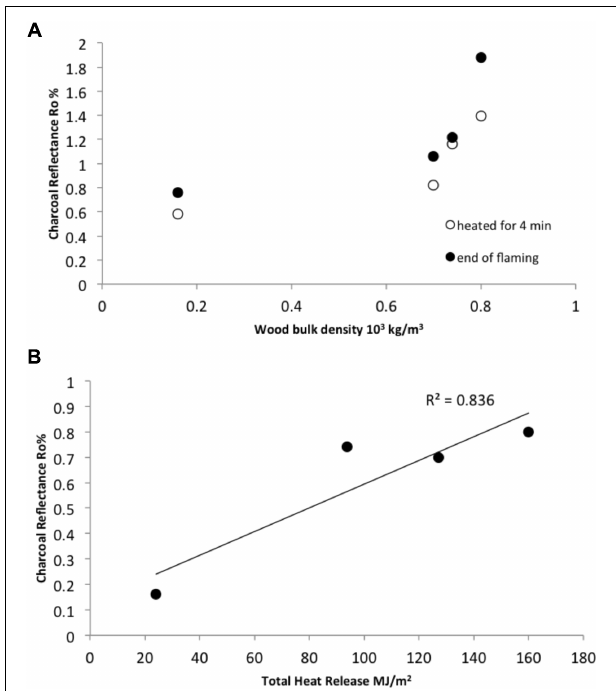
FIGURE 6 | The influence of wood bulk density on charcoal reflectance. (A) Indicates bulk density and charcoal reflectance for samples subject to 4 min of flaming combustion and sampled at the end of flaming combustion. (B) The mean total heat released measured at the end of flaming combustion four different bulk density woods and the corresponding mean charcoal reflectance attained for each bulk density set. The mean of 90 measurements is represented by each data point on both